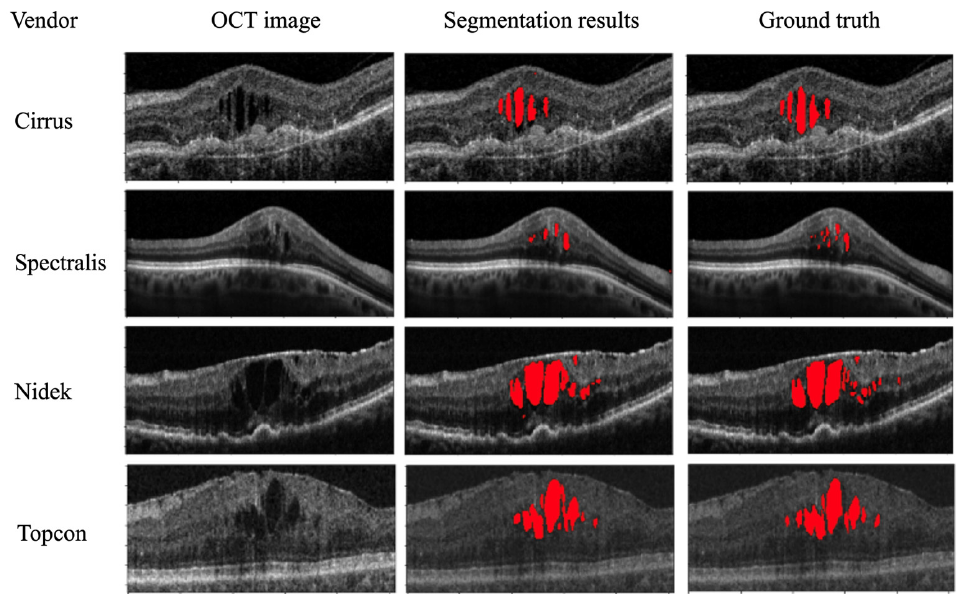
Figure 1. Illustration of cyst/fluid regions and segmentation results in OCT images [9]. The OCT images were acquired with scanners from various vendors, including Topocon, Cirrus, Spectralis, and Nidek. The first column of subfigures shows the OCT images, the red region in the second column shows the algorithm’s automated segmentation results, and red region in the third column shows the expert-annotated ground truth of the cyst/fluid regions.